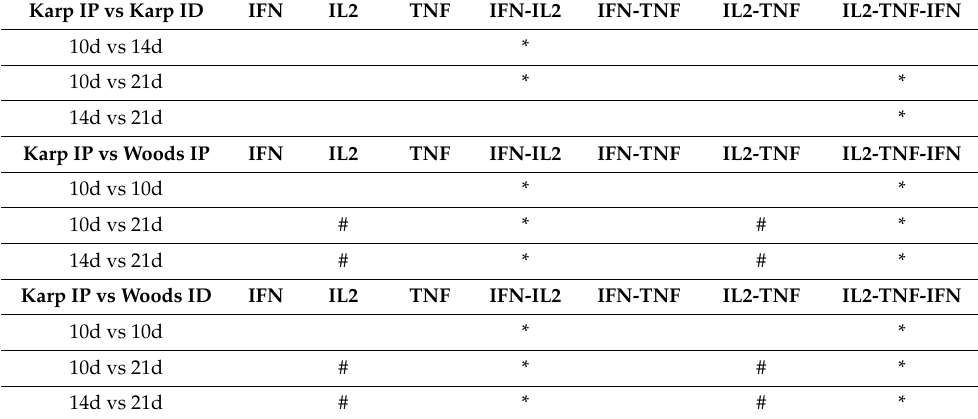
Table 3. Summary of the CD4+ T-cell population lethal and nonlethal (protective) cytokine signatures. Comparisons between lethal (Karp IP) and nonlethal (Karp ID, Woods IP, Woods ID) challenge models were performed in an intra- and interstrain fashion. Lethal signatures are designated by an asterisk (*) and nonlethal (protective signatures) are indicated by a hashtag (#), each indicating a significant increase ( p < 0.05) in the associated population of cytokine-producing